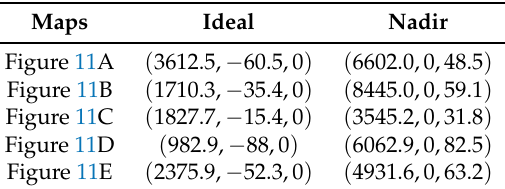
Table 4. Reference